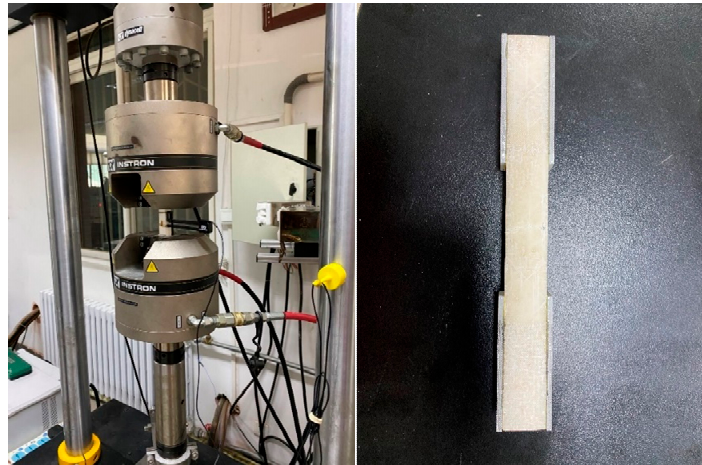
Figure 1. Experimental setup for the tensile testing of the specimens.